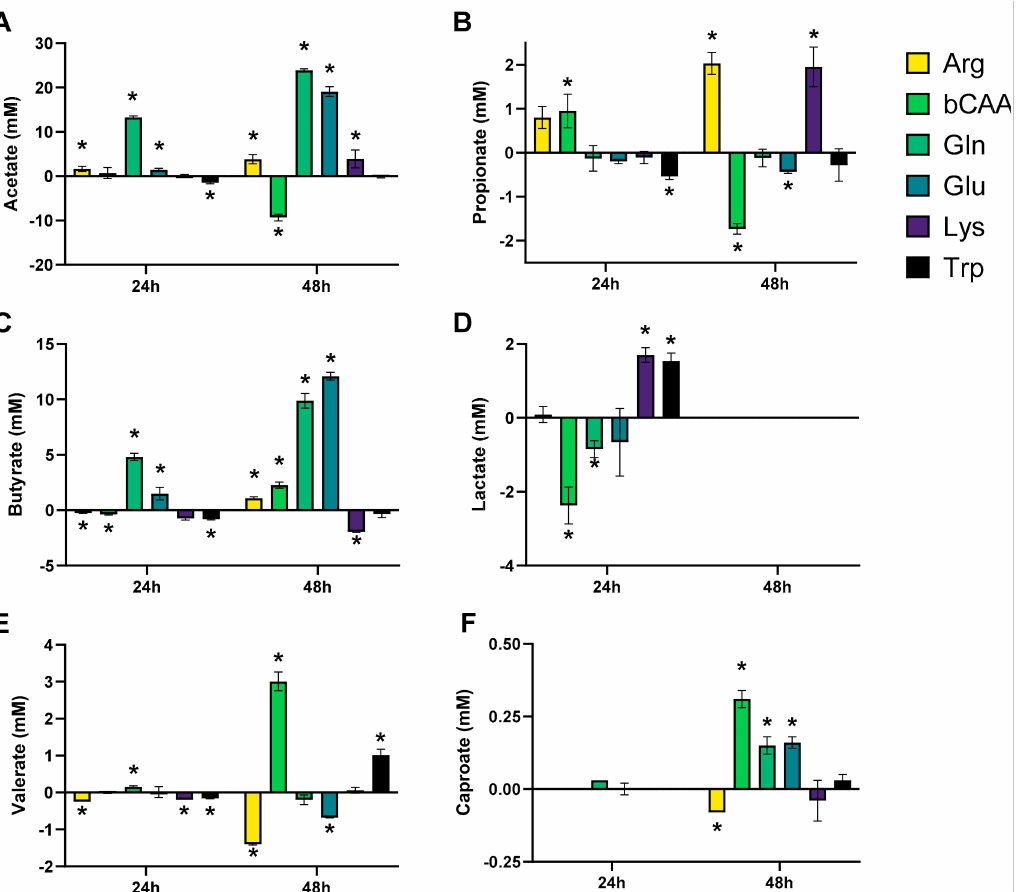
Figure 4. Effect of amino acids on microbial fermentation products (SCFA (acetate ( A ), propionate ( B ), butyrate ( C ), valerate ( E ), and caproate ( F )) and lactate ( D )) upon incubation with a porcine colonic microbiota ( n = 3). The data is presented as the average ( ± SD) difference versus a corresponding blank incubation. Statistically significant differences are indicated with asterisks (* p <